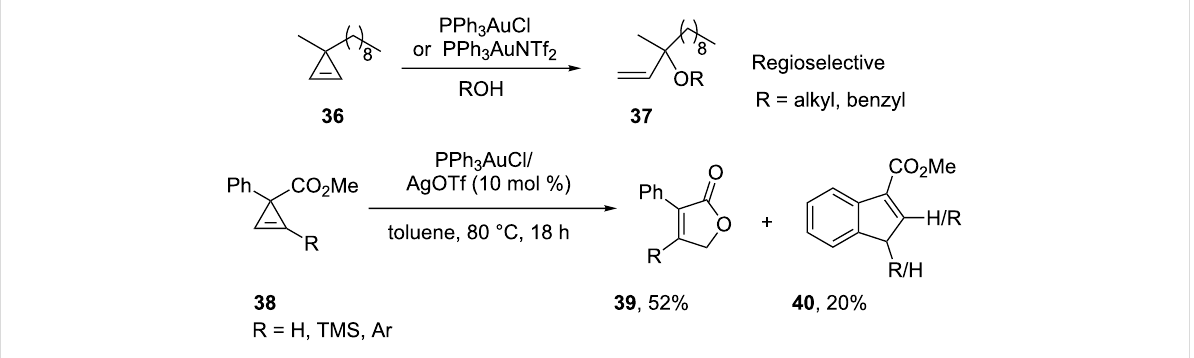
Scheme 7: Gold-catalyzed ring-opening of cyclopropenes.